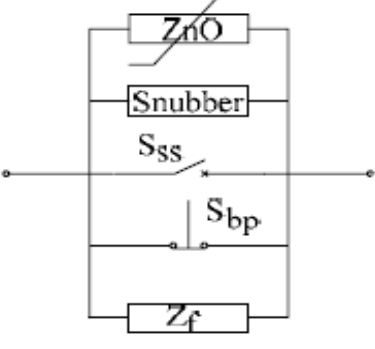
Figure 16 . Series switch-type FCL. Figure 16. Series switch-type FCL.